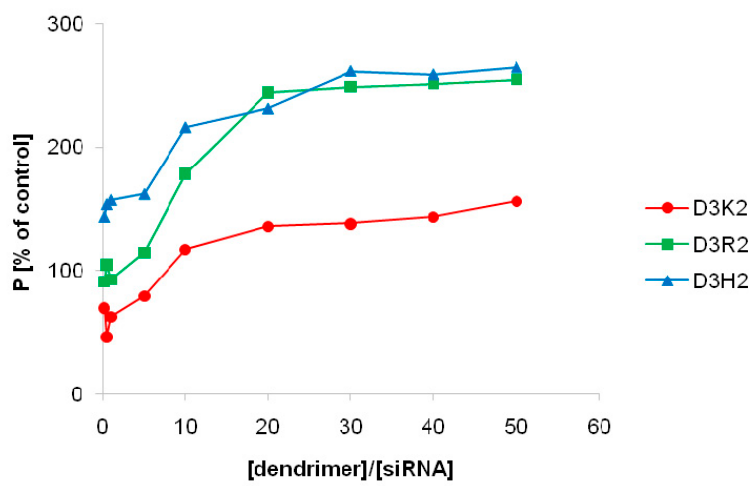
Figure 2. Changes in siRNA-FITC fluorescence polarization as a function of dendrimer:siRNA molar ratio. Results are presented as percentage of control (average ± SD, n = 3).